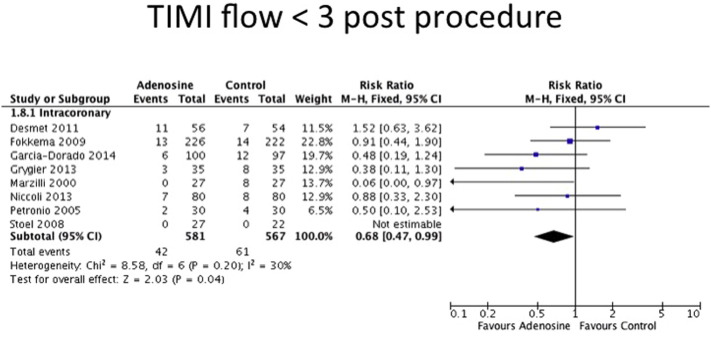
Forest plot for myocardial blush grade 0 or 1, adenosine v control.